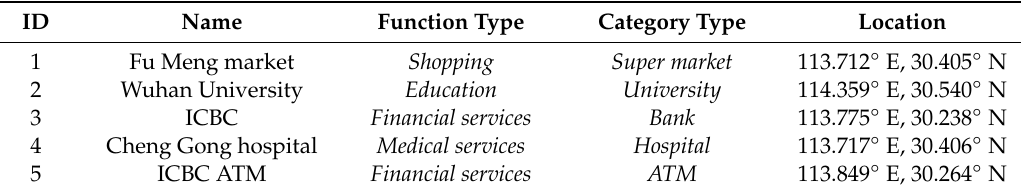
Table 1. POI samples.